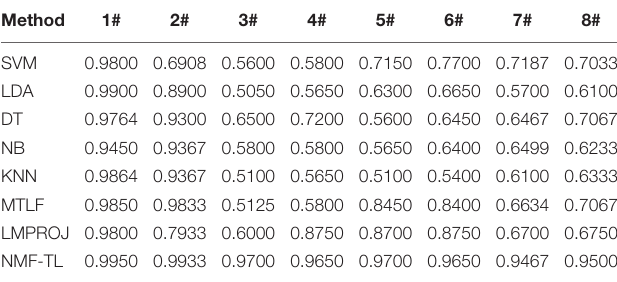
TABLE 4 | Classification accuracy comparison of 8 classifiers on datasets based on SIFT feature extraction.